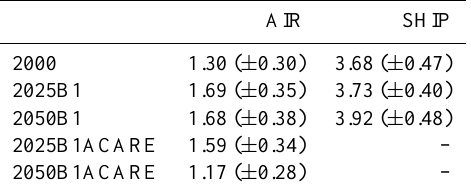
Table 4. Relative changes (%) in methane lifetimes (integrated up to 50hPa) due to a 5% decrease in traffic emissions. Values are given relative to the BASE case, and are scaled to 100% by multi- plying with 20. Both the mean of the six models and the standard deviations (indicating the spread of the models) are given. Note that this table does not include the feedback effect of methane changes on its own